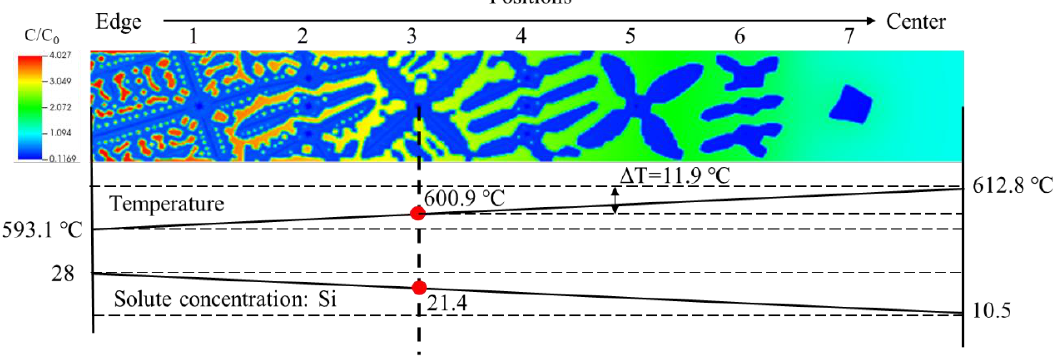
Figure 12. Schematic of the conditions about temperature and solute concentration for detachment of secondary arms. secondary